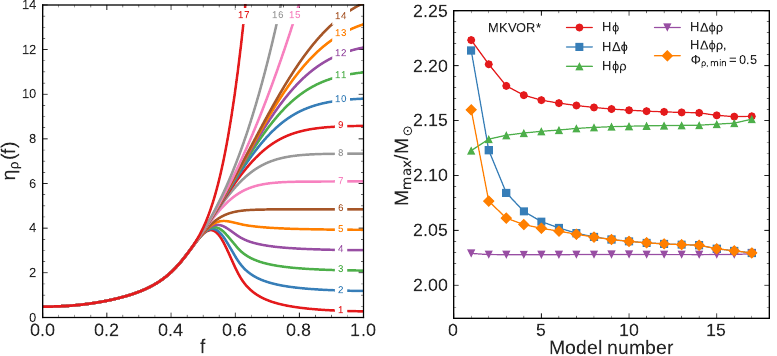
( i ) = 1 . . . 17 as functions of the scalar field f . Right panel : Figure 3. Left panel : Scaling functions η ρ for i Maximum NS mass as a function of the model number for MKVOR*{H φ , H ∆ φ , H φρ , H ∆ φρ } models with Φ ρ ( f ) = 1 − f and for MKVOR*H ∆ φρ with Φ ρ given by Equation (7) with Φ ρ ,min =